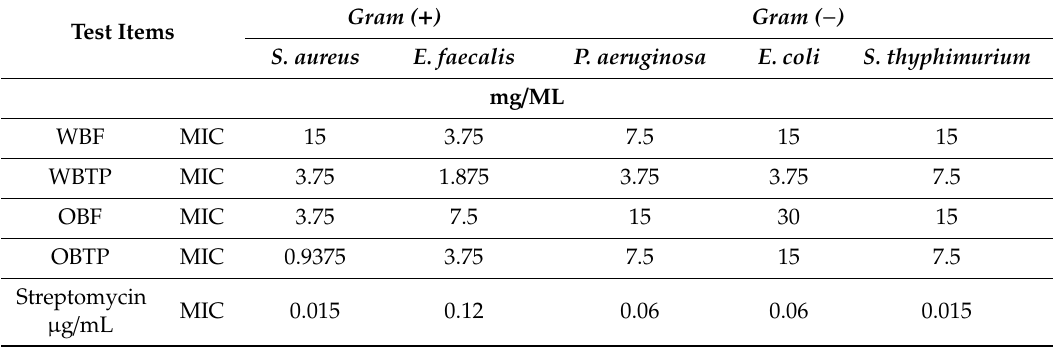
Table 4. Minimum inhibitory concentration (mg wheat / oat bran / mL) of the WB and OB extracts before and after thermal processing.